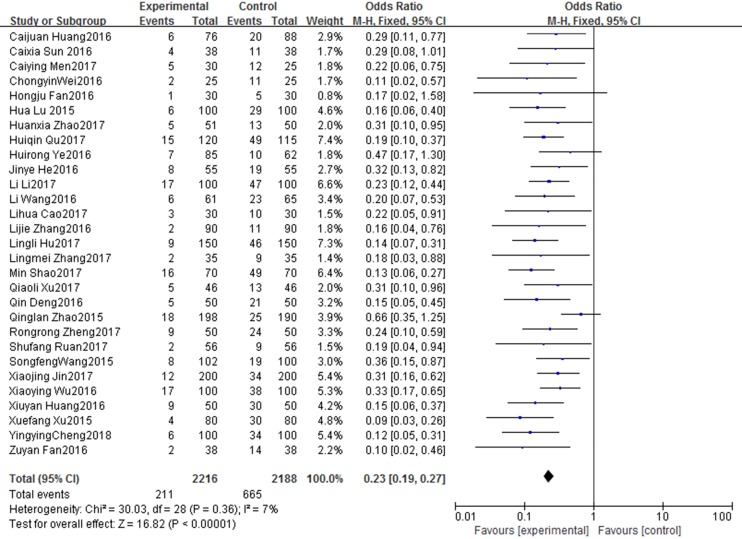
Forest plot diagram showing complications of patients with PICC after discharge in WeChat group and traditional group.Each square indicates a study, and the area of squares is proportional to the weight of the study. The diamond represents the summary OR and 95% CI. CI = confidence interval, OR = odds ratio.